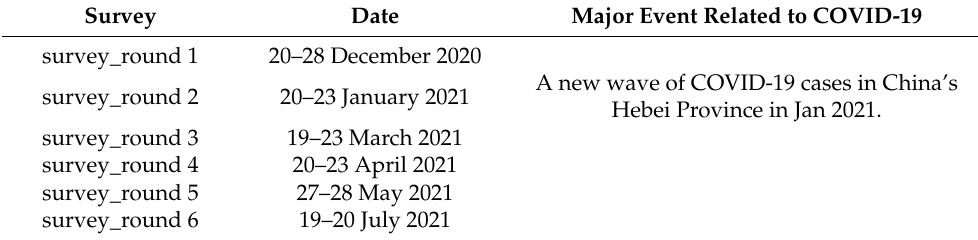
Table 2. Survey time and major